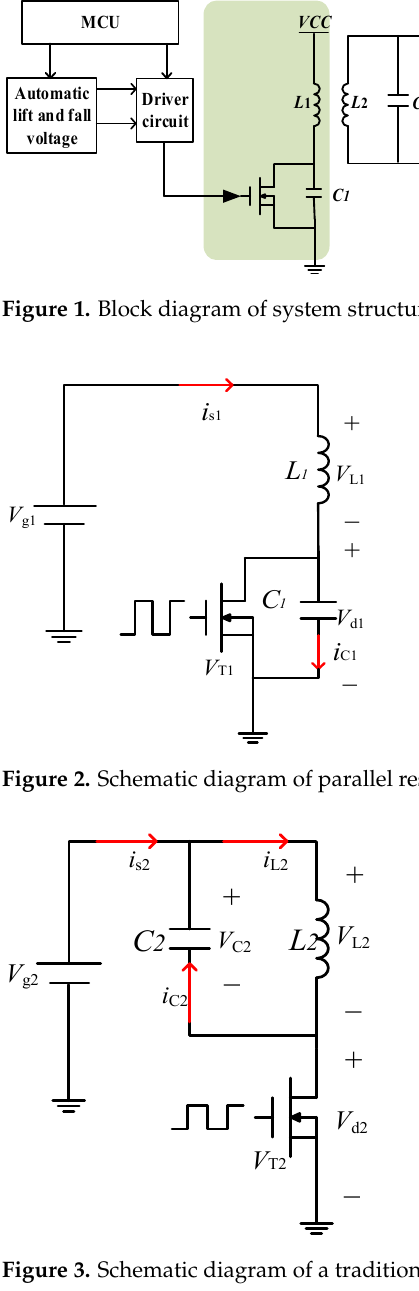
Figure 3. Schematic diagram of a traditional transmitter circuit.